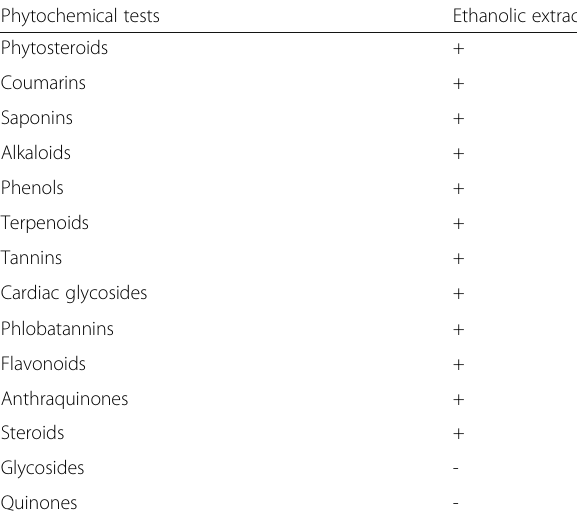
Table 2 Phycochemical screening of ethanolic extract of